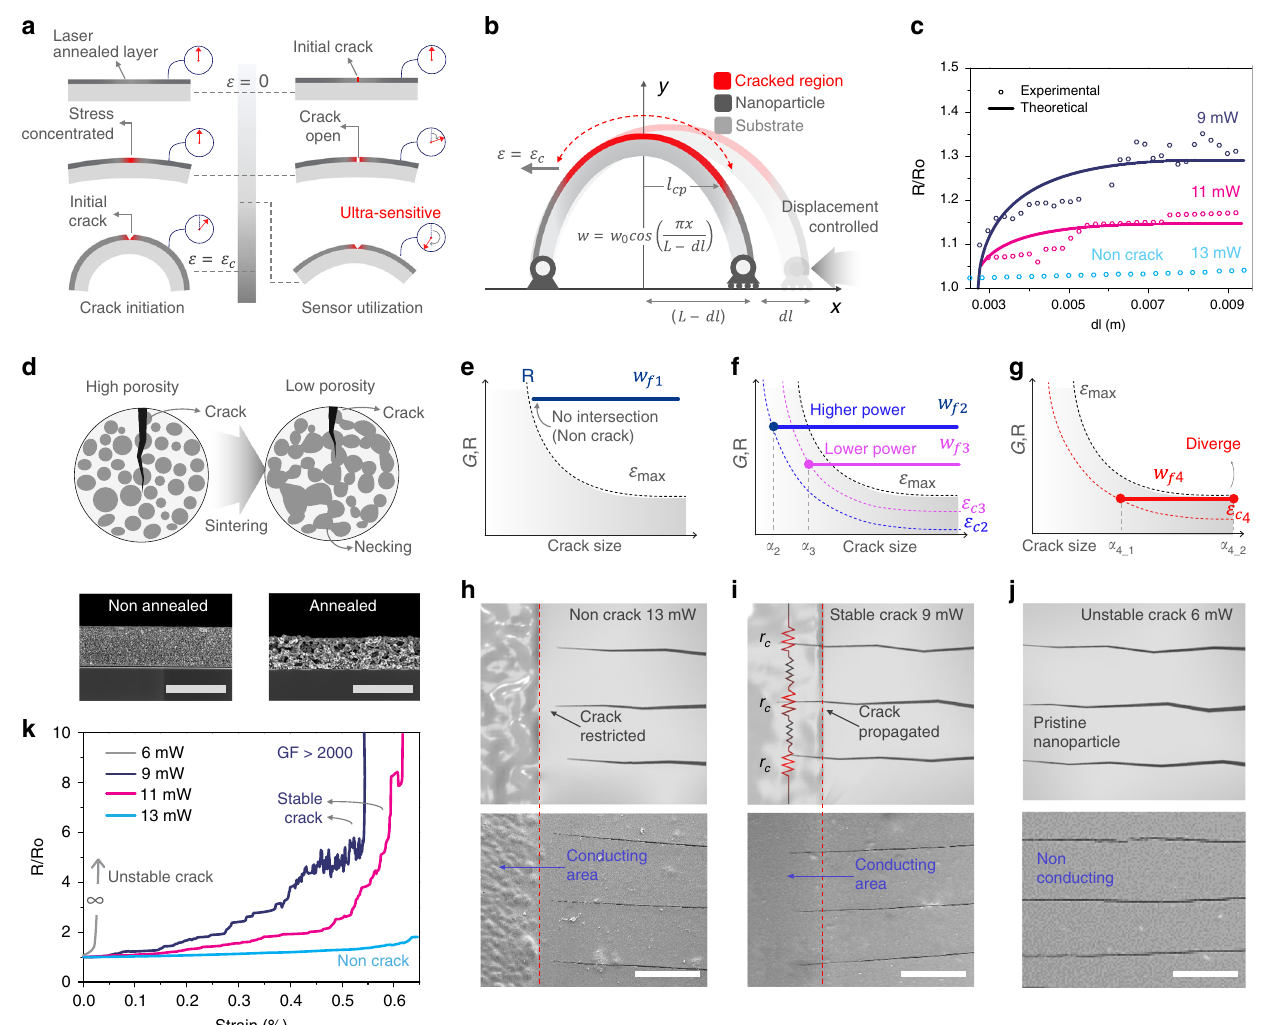
Fig. 3 Investigation of crack characteristics. a Electrical response while initial cracking (left) and sensor operation (right). b Schematic illustration and modeling parameters of displacement controlled bending environment. c The initial cracking resistance changes of the sensors prepared by different laser power with model- fi tting curve. d Schematic representation of sintered particle layer and SEM image of the cross section of annealed (right) and non- sintered (left) particle layer. Scale bar, 40 μ m. e – g Energy release rate curve and resistance function of “ non-cracking ” ( e ), “ stable cracking ” ( f ), and “ unstable cracking ” ( g ). Arrow at the bottom describes the increasing direction of electrical conductivity (blue) and degree of crack (gray). h – j Crack appearance for each regime, “ non-cracking ” ( h) , “ stable cracking ” ( i ), and “ unstable cracking ” ( j ). The fi rst row indicates the schematic of crack length and the second shows the SEM images respect to each case. Scale bar, 14 μ m. k The operating output resistance of the sensors prepared by different laser